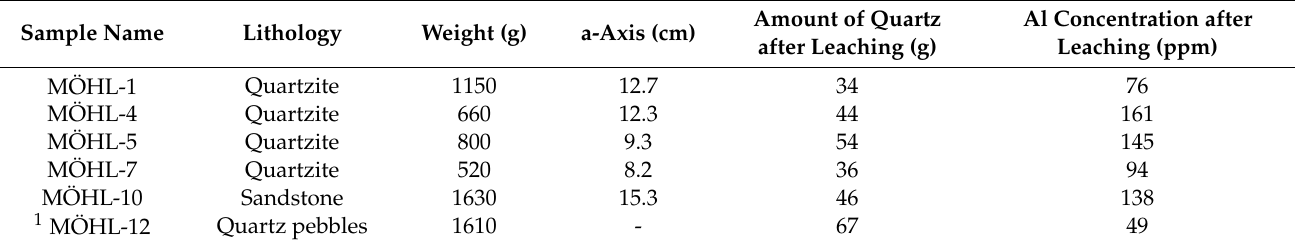
Table 1. Sample information for the Möhlin